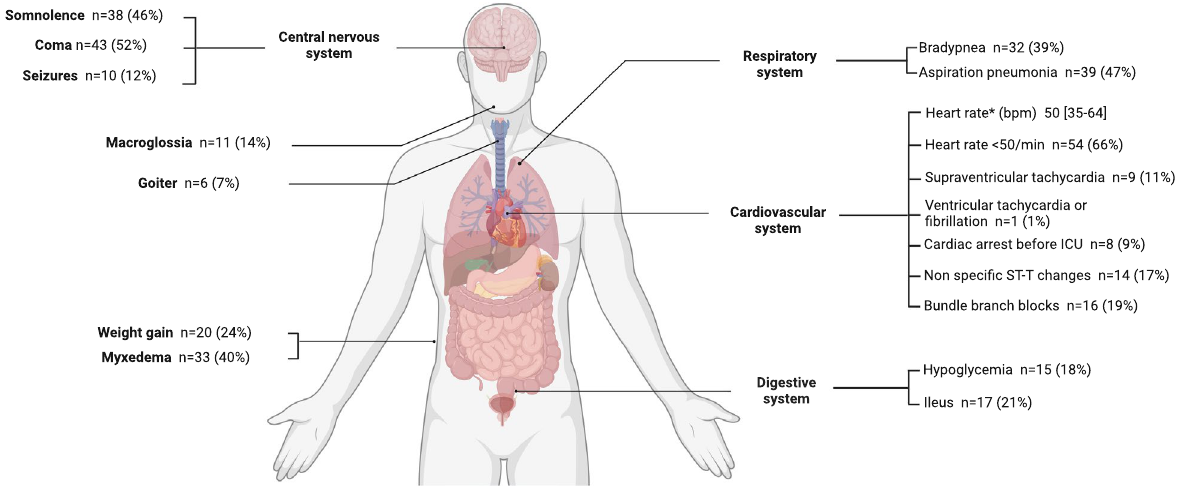
Fig. 1 Main clinical presentation of severe hypothyroidism in critically‑ill